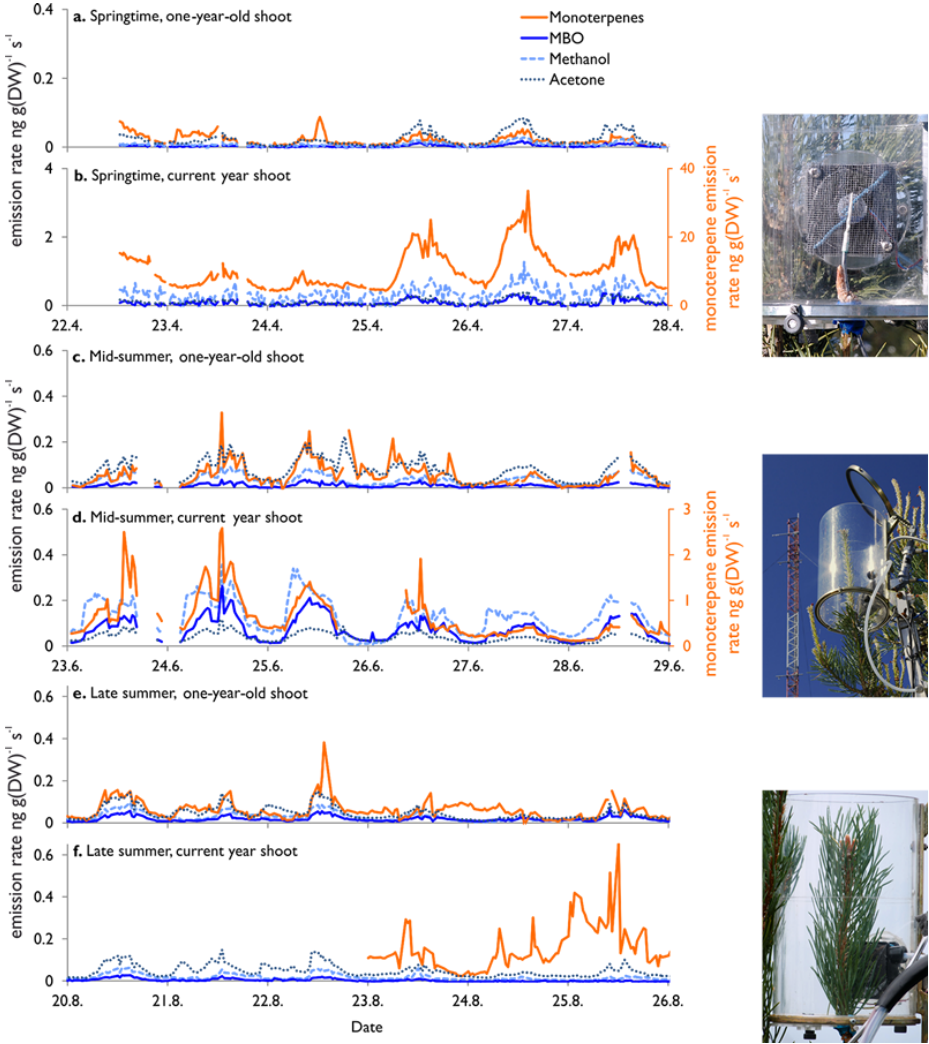
Fig. 2. Monoterpene, MBO and methanol emission rates from developing and mature Scots pine shoots. (a, b) 22–27 April 2010, during the dormancy break, before any growth commences. (c, d) 22–28 June 2010, during the most intensive needle elongation period. (e, f) 20–25 August 2010 when the shoot length growth has ended. NOTE: In panels (b) and (d) , monoterpene emission rates of the current year bud/shoot are given in the right y axis due to magnitude differences in emission rates. Next to panels (b) , (d) and (f) photos from the corresponding stage of shoot